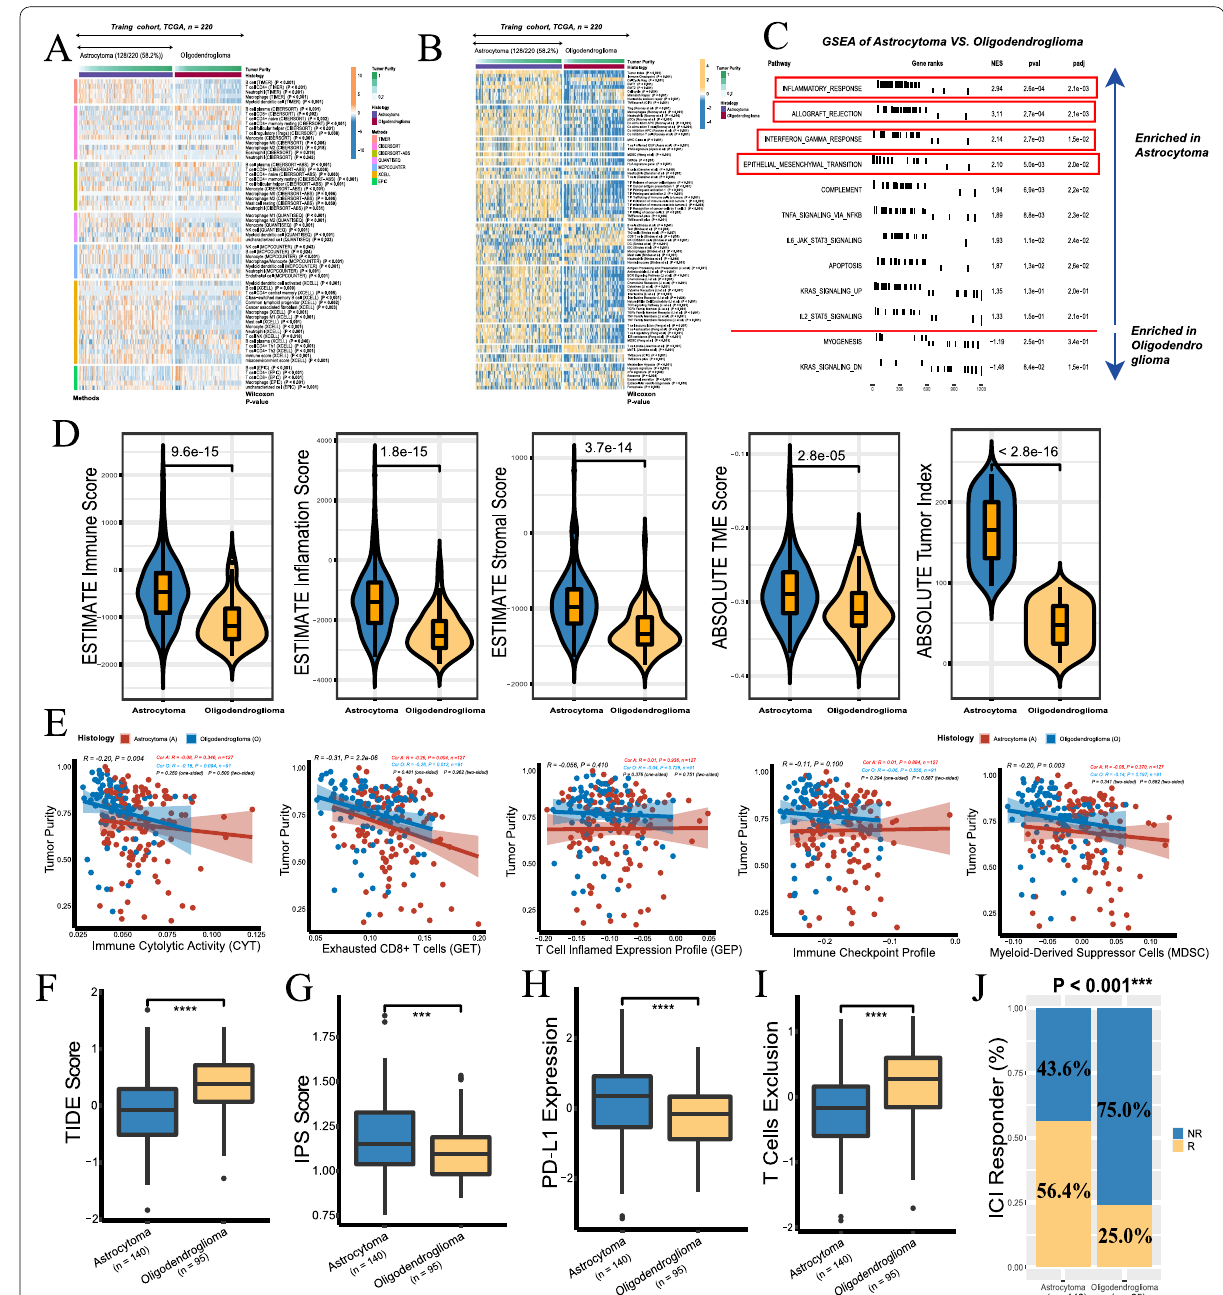
Fig. 5 Immune infiltration landscape and checkpoint immunotherapy response in tumors. A Immune cell infiltration calculated using multiple computational methods in tumors. Wilcoxon test P-value was attached behind the cell name. B Multiple immune and TME signatures calculated using the IOBR method in tumors. Wilcoxon P-value was attached behind the cell name. C GSEA indicates an enhanced immune phenotype enriched in astrocytoma. D TME and tumor-related scores quantified using ESTIMATE/ABSOLUTE algorithms (Wilcoxon rank-sum test). High immune score and inflammation score indicates infiltrative immune cells, high stromal score indicated large proportion of stromal cells, higher TME score indicates large proportion of nontumor cells (primarily immune stromal cells), high tumor index indicates great + tumor malignancy and progression. E Correlation between tumor purity and immune cell function. Spearman R with p-values presented. A, astrocytoma, O, oligodendroglioma. F Astrocytoma had a lower TIDE score than oligodendroglioma. G Astrocytoma had a higher IPS score than oligodendroglioma. H Astrocytoma had higher relative PD-L1 expression than oligodendroglioma. I Oligodendroglioma had a higher level of T cell exclusion (***Wilcoxon P < 0.001; ****P < 0.0001). J The proportion of immunotherapy responders and nonresponders between astrocytoma and oligodendroglioma, Chi-square test P < 0.001 (***P < 0.001). ICI, immune checkpoint